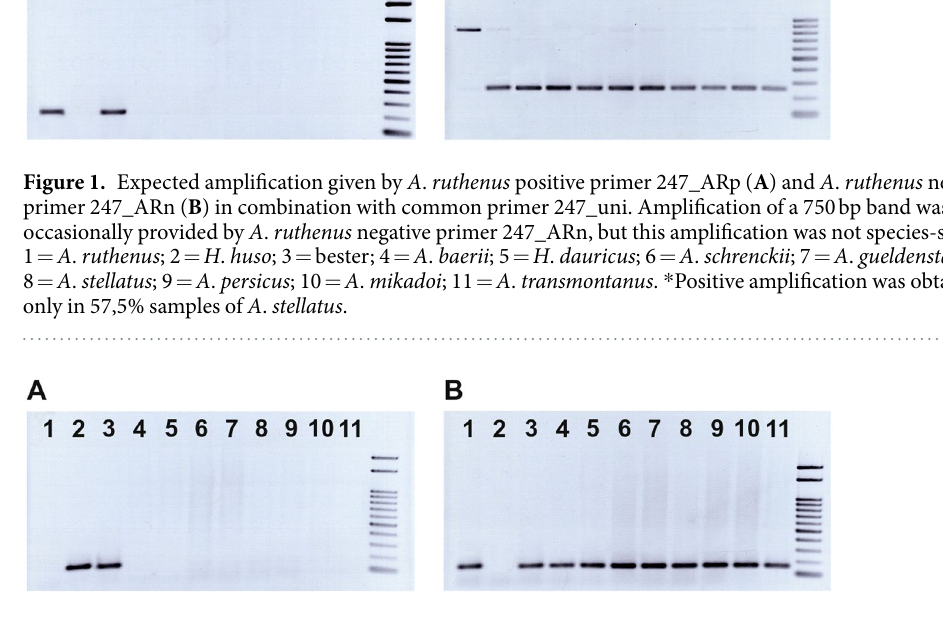
Figure 2. Expected amplification given by H . huso positive primer 153_HHp ( A ) and H . huso negative primer 153_HHn ( B ) in combination with common primer 153_uni. 1 = A . ruthenus ; 2 = H . huso ; 3 = bester; 4 = A . baerii ; 5 = H . dauricus ; 6 = A . schrenckii ; 7 = A . gueldenstaedtii ; 8 = A . stellatus ; 9 = A . persicus ; 10 = A . mikadoi ; 11 = A . transmontanus